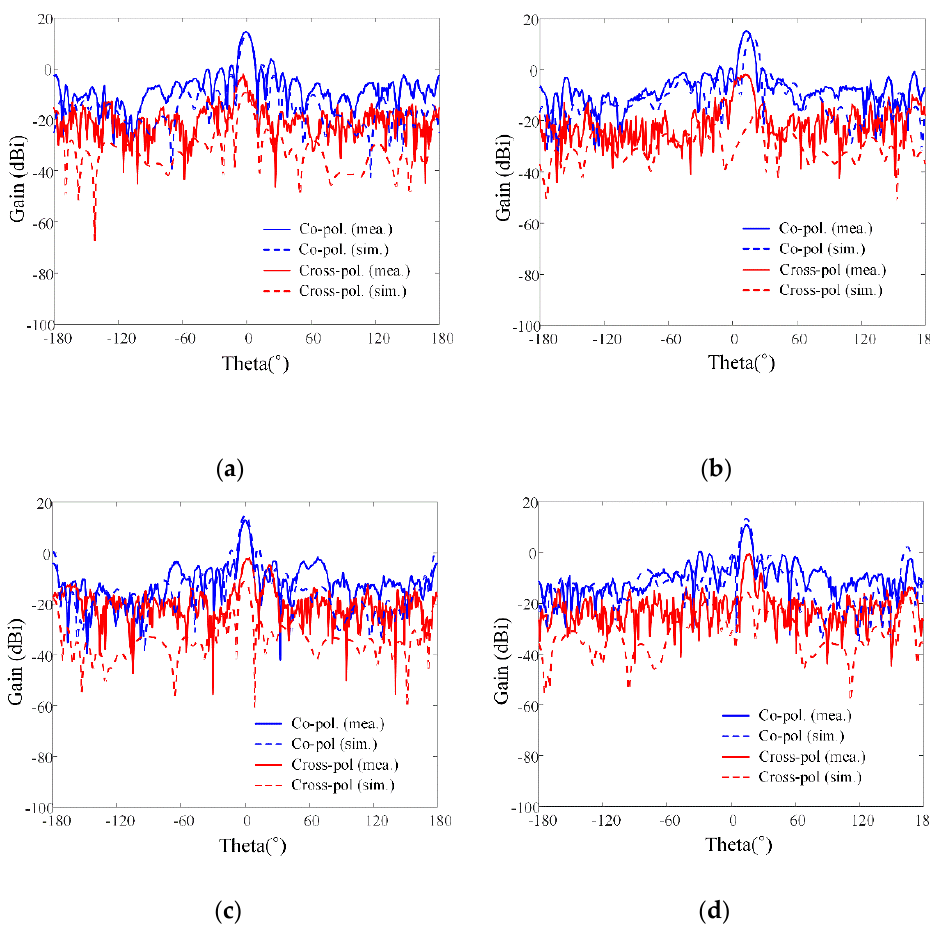
( b ) Figure 9. The measured and simulated mutual couplings: ( a ) the mutual couplings for port 1 to port 5; ( b ) the mutual couplings for port 7 to port 11. Figure 10 shows the beam steering characteristics with steering angles, θ 0 , of 0° and 15° at 4 GHz and 5 GHz. The solid and dashed lines indicate the measurements and sim- ulations, and the blue and red lines denote the radiation patterns of the co- and cross- polarization. The measured and simulated results are well matched to each other. The measured bore-sight array gains of the co-polarization are 13.4 dBi and 13.7 dBi at 4 GHz and 5 GHz, and those of the cross-polarizations are − 4.9 dBi and − 3.4 dBi, respectively. When the beam is steered at the steering angle, θ 0 , of 15°, the maximum measured array gains of the co-polarization are 12.2 dBi and 10.3 dBi at 4 GHz and 5 GHz, respectively. Moreover, the co-and cross-polarization level differences at the angle of the maximum gains are 14 dB at 4 GHz and 11.4 dB at 5 GHz. Note that these beam steering results were calculated considering the ideal gain increment of the 11 elements from the bore-sight